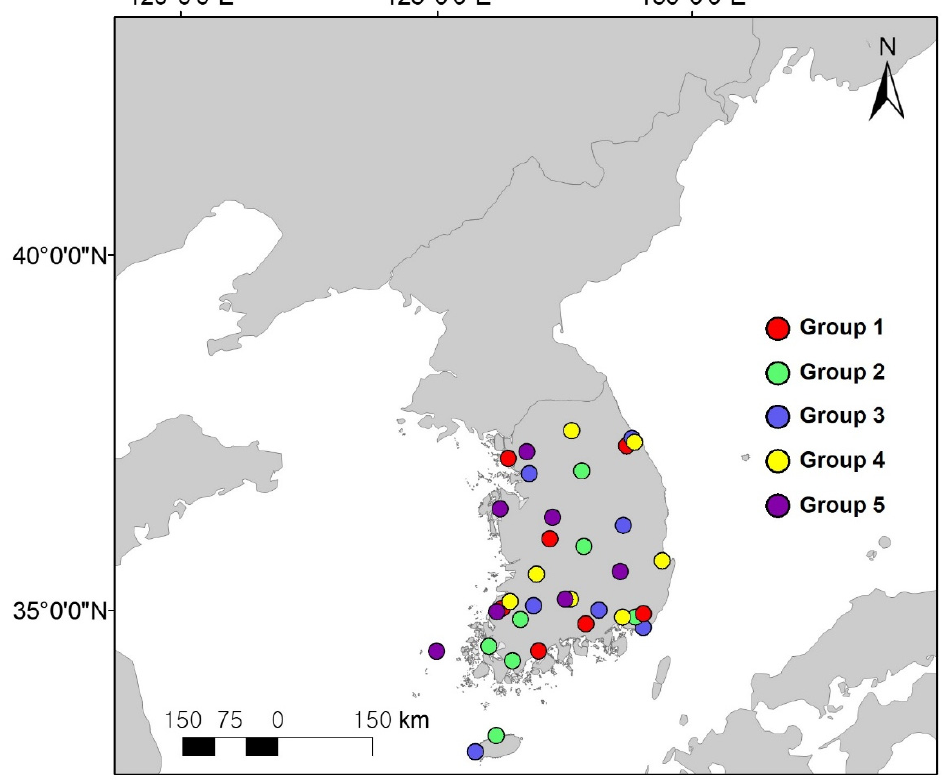
Figure 1. Study area, including ground station locations used for estimating solar radiation. Groups employed for five-fold cross-validation are indicated by colored circles.